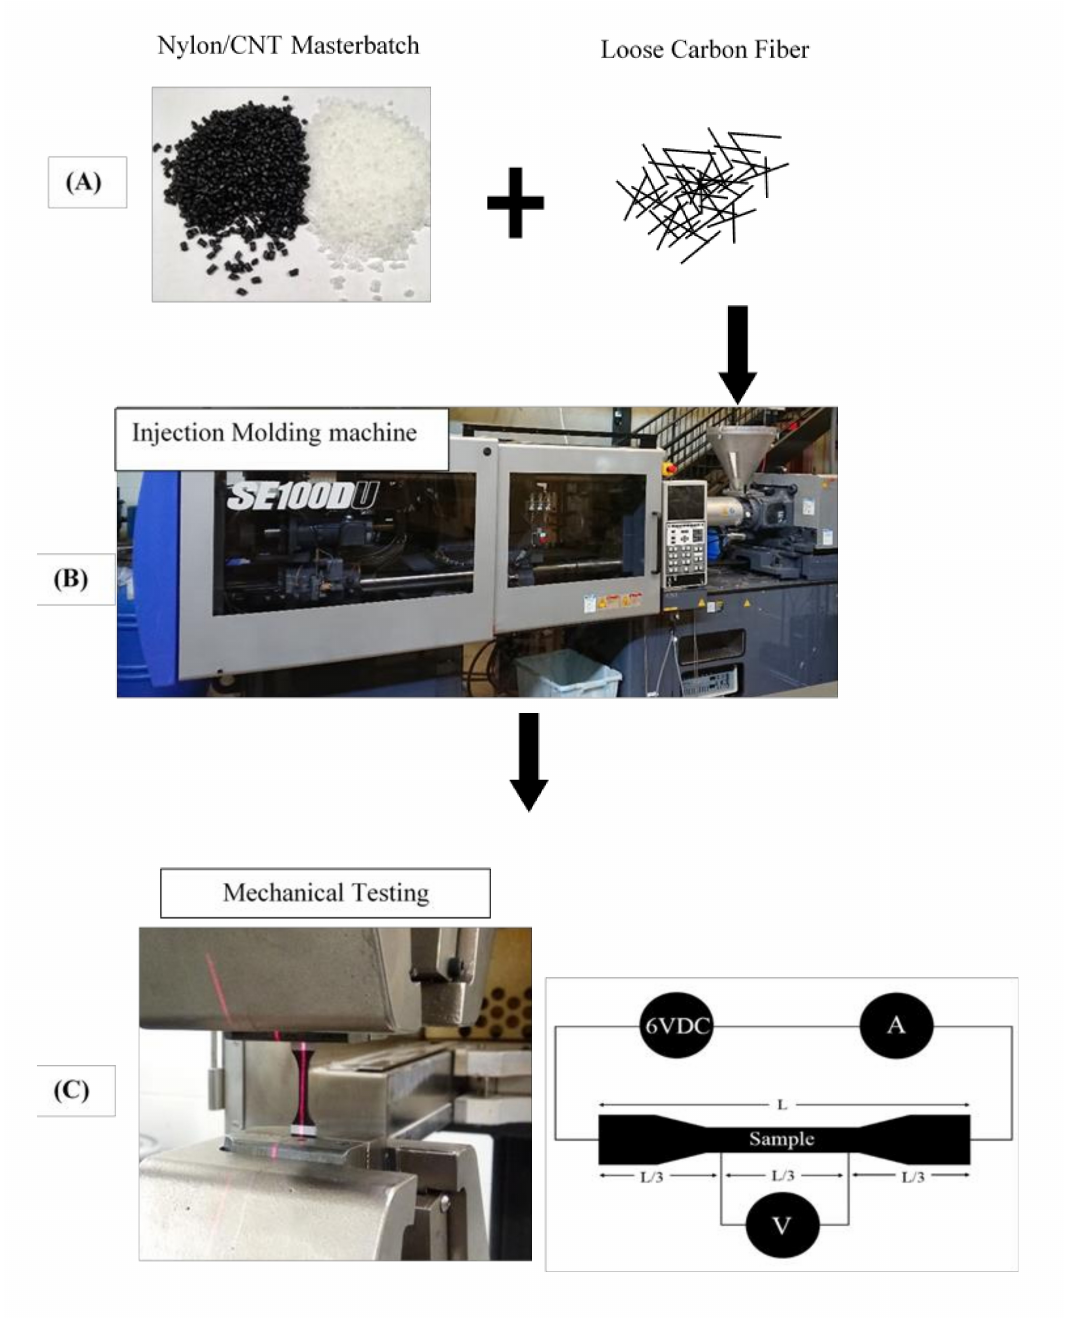
Figure 1. Manufacturing and testing process flowchart; ( A ) composition, ( B ) manufacturing, ( C )